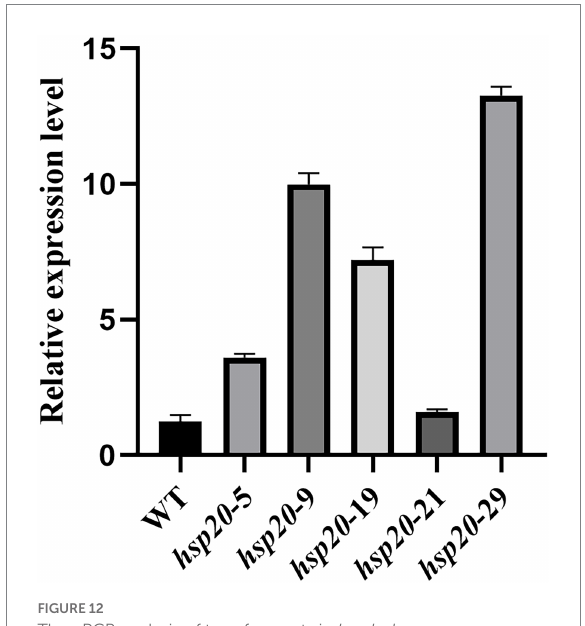
FIGURE 12 The qPCR analysis of transformants in L.